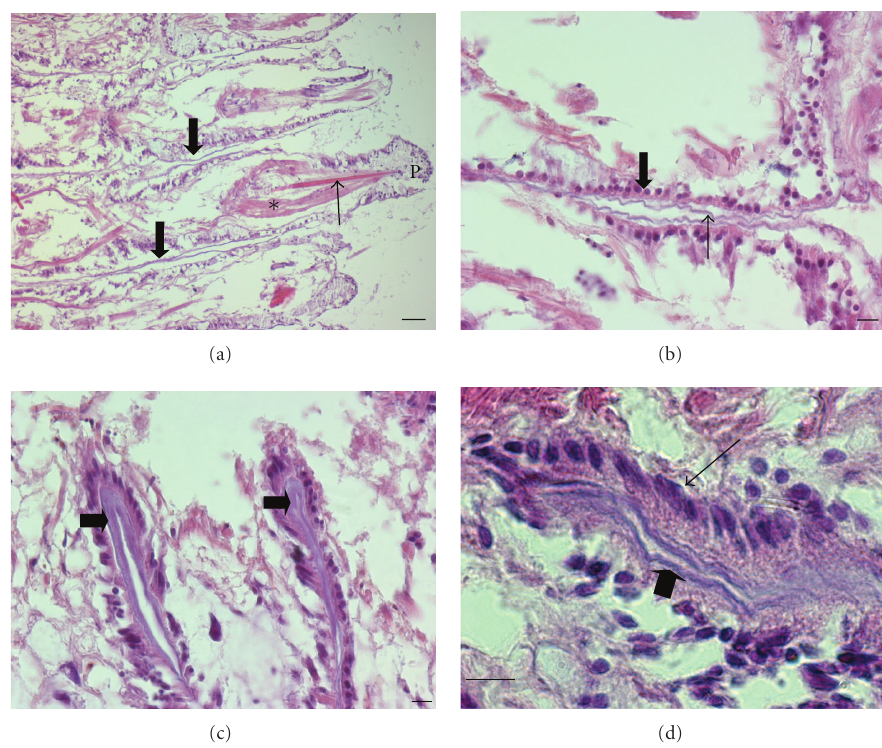
Figure 2: Histology of the integument of Newfoundland Ophryotrocha sp. (a) Overview of the epidermis and cuticle showing detail of parapodia (note muscular support structure (asterisk) and chaeta (thin arrow)) and orientation of mucus channels. Thick arrows indicate a thin layer of mucus (scale bar = 5 µ m). (b) Detail of mucus channel showing secretory cells with basal nuclei and eosinophilic apical cytoplasm (thick arrow). Note thin mucoid secretion on the luminal surface of cells lining channel (thin arrow) (scale bare = 1 µ m). (c) Detail of mucus channel from anterior portion of worm. Note the presence of a more viscous mucoid secretion (thick arrows) in this region compared to the previous (Scale bar = 1 µ m). (d) Detail of cells lining anterior glandular structure. Note basal nucleus and granular apical cytoplasm (large arrow) with associated viscous secretion (arrowhead) (scale bar = 1 µ